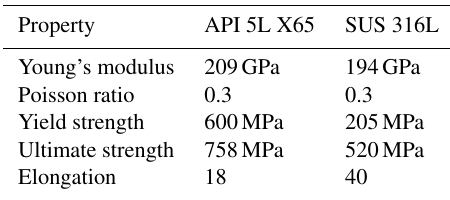
Figure 7. Arithmetical average roughness of each condition. Table 2. Material property of each